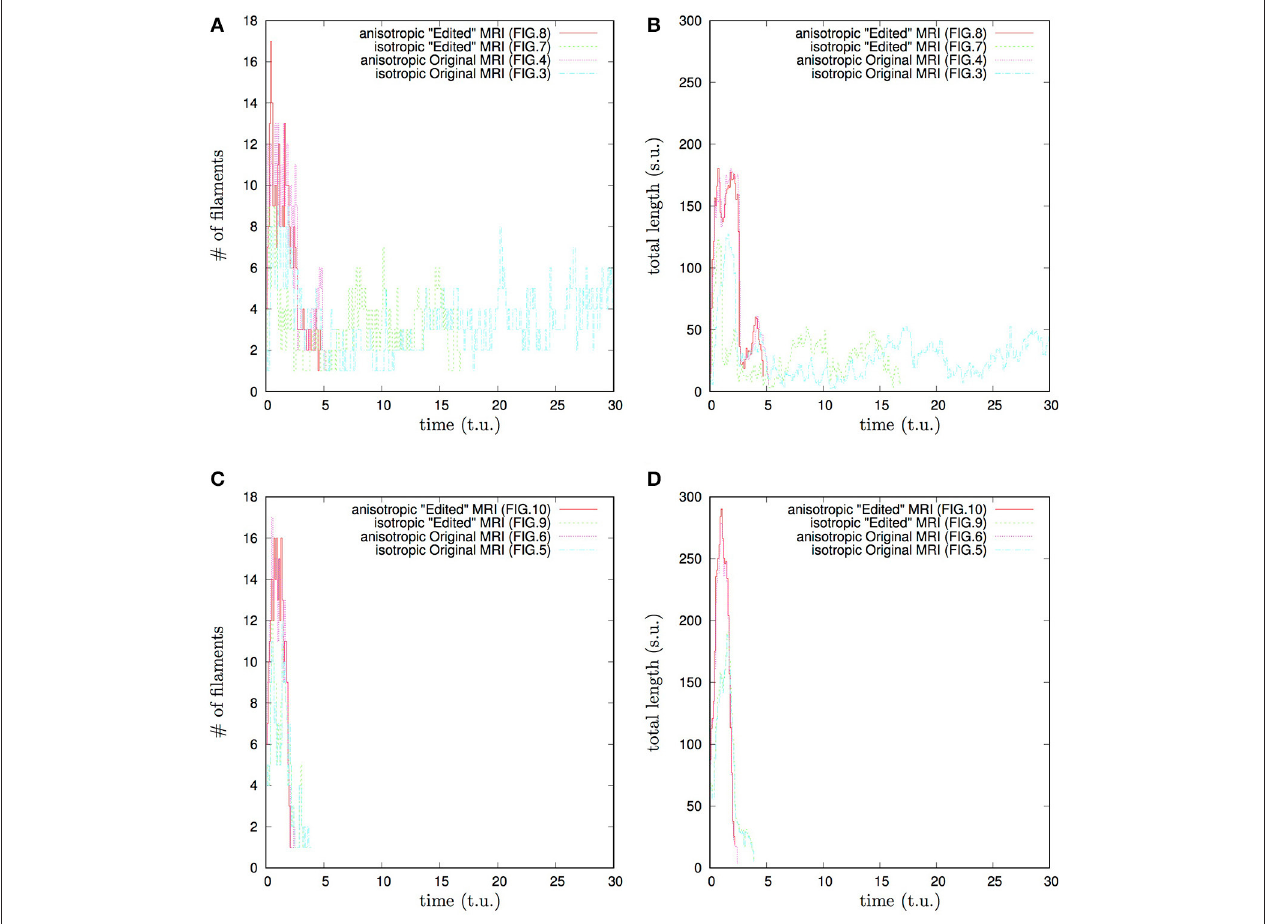
FIGURE 12 | Whole heart simulation: time course of the number of filaments #, and of the total length of the filaments, time and the total length of the filaments shown in the time and space units of Equations (1, 2). Initial position of the vortex filament along the x axis , Figures 3 , 4 , 7 , 8 simulations: (A) time course of the number of filaments # ; (B) time course of the total length of the filaments. Initial position of the vortex filament along the y axis , Figures 5 , 6 , 9 , 10 simulations: (C) time course of the number of filaments # ; (D) time course of the total length of the filaments. Anisotropy increases the transient number and the transient total length of the filaments. The bigger transient number and the total length of the filaments tend to correlate with the faster termination of re-entry. The biggest transient total lengths of the filaments was in case of the re-entry initiated along the y axis , (D) , which ensured its fastest termination. It can be seen from Figures 5 , 6 , 9 , 10 , that the initial position of the filament along the y axis allowed it to grow intramurally, thus maximally increasing the transient total length of the filaments, and speeding up their